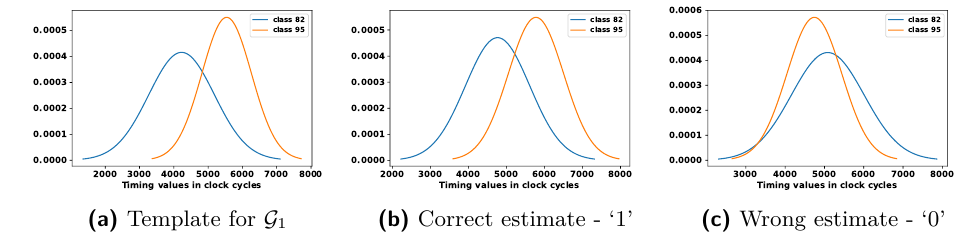
Figure 7: Template matching for bit index